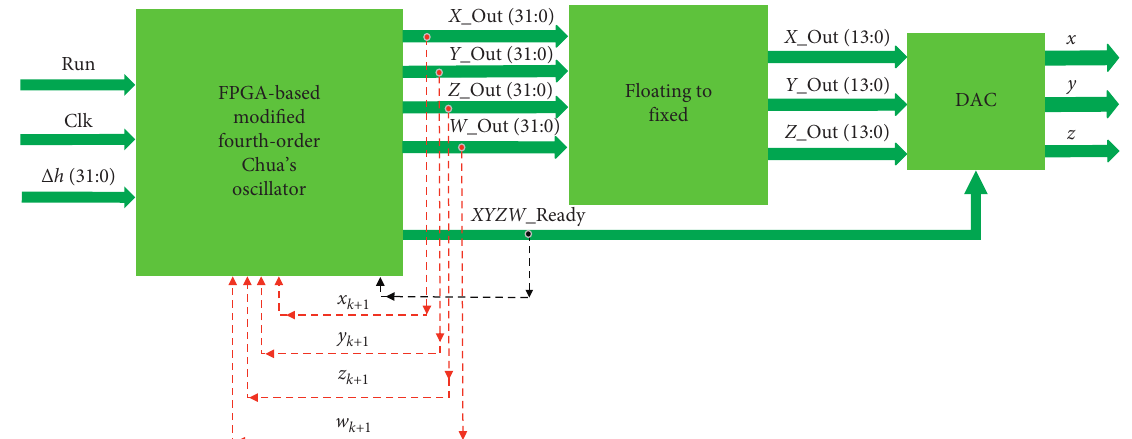
Figure 16: The second level block diagram of the FPGA-based multistable modified Chua’s chaotic